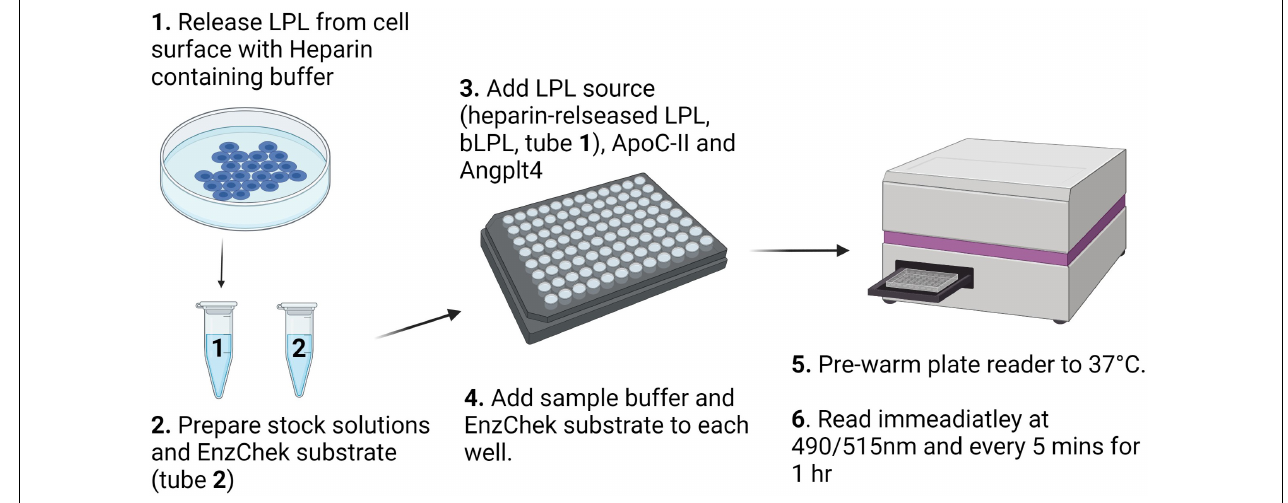
FIGURE 2 | Schematic description of the workflow for the fluorescence detection of LPL activity using the EnzChekTM